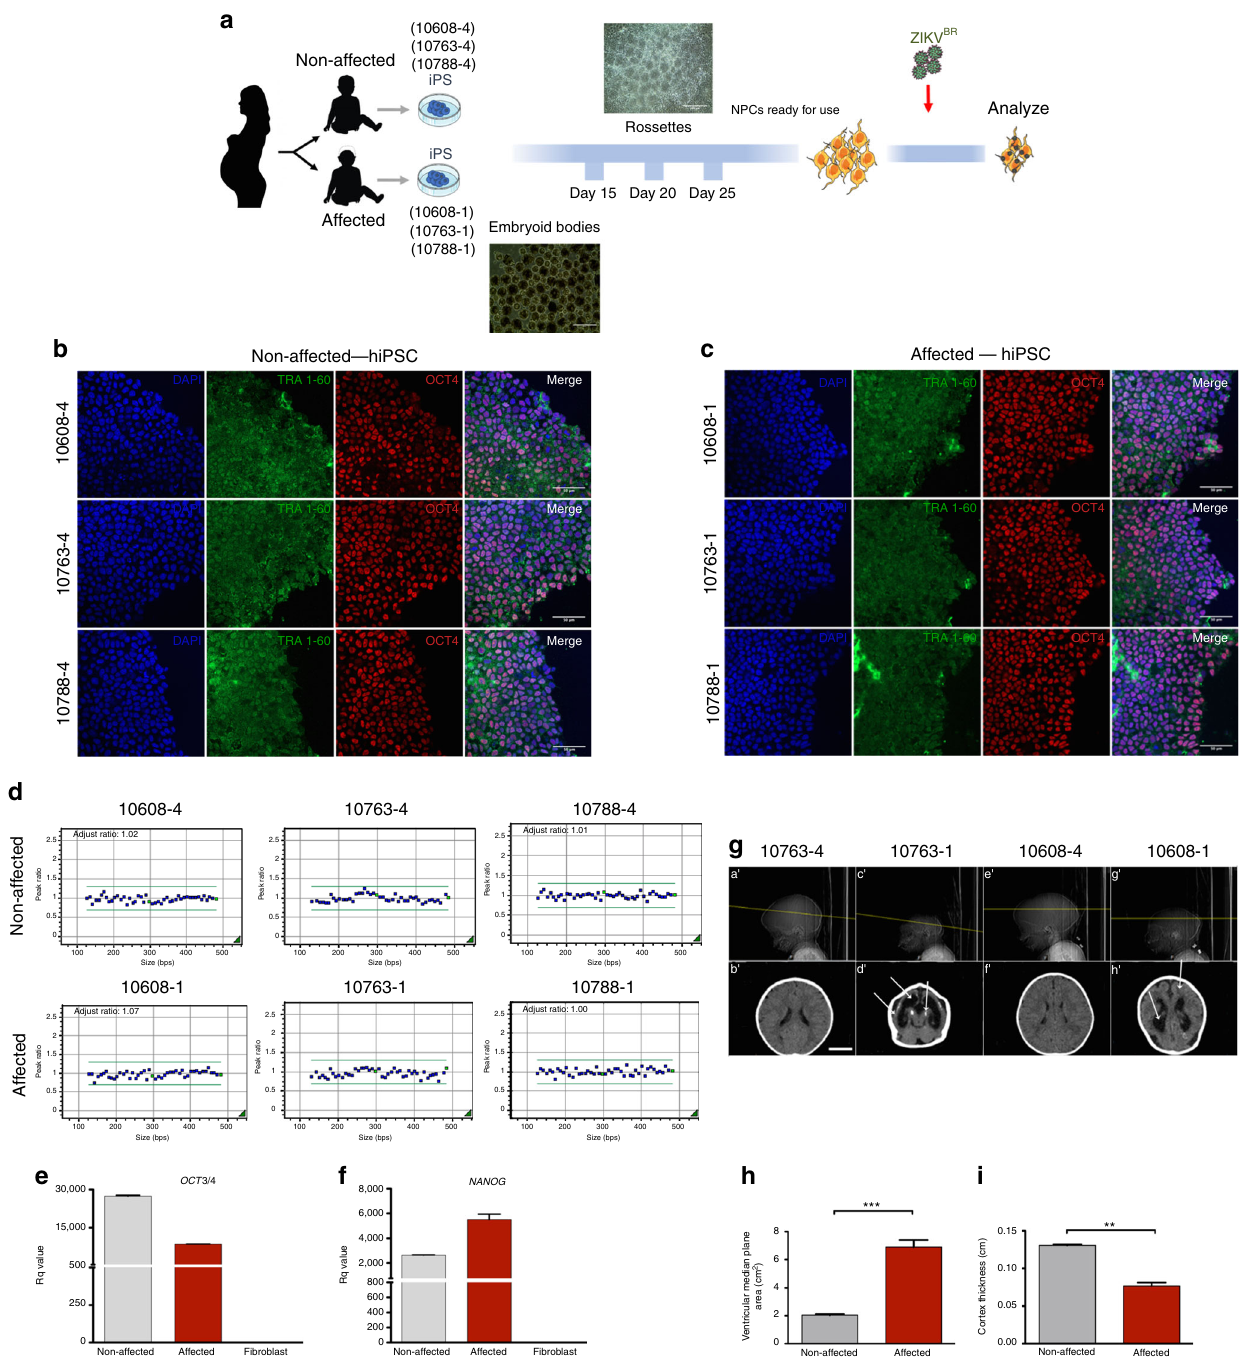
Fig. 1 Experiment design and hiPSC characterization. a Schematic: generation of neural progenitor cells (NPCs) from discordant twins ’ hiPSCs following ZIKV BR infection and analysis. Silhouettes are courtesy of www.vecteezy.com (mother) and Yulia Ryabokon (babies). b , c Immuno fl uorescence for TRA-1- 60 and OCT3/4 in hiPSCs. Scale bar, 20 μ m. d MLPA analysis of subtelomeric imbalance chromosomal abnormalities in cultured hiPSCs cell lines using P070 and P036 MLPA Kits. e , f RT-qPCR analysis of hiPSCs for OCT3/4 and NANOG expression (mean ± SEM). g Representative discordant twins ’ computed tomography (CT) scan images (a ′ , b ′ [#10763-4]; e ′ , f ′ [#10608-4] — non-affected babies; c ′ , d ′ [#10763-1], g ′ , h ′ [#10608-1] — affected babies). #10608 twins were 5 months old and #10763 were 15 months old when submitted to CT scan. White arrows show observed brain abnormalities (calci fi cations, ventriculomegaly, and cortical gyrus simpli fi cation). Scale bar, 3 cm. h Ventricular area analysis (cm 2 ) ( n = 4, two pairs of discordant twins). i Cortex thickness analysis ( n = 4, two pairs of discordant twins). *** p < 0.001; ** p < 0.01; mean ± SEM; Student ’ s t test RNA-Seq analysis . RNA sequencing (RNA-Seq) analysis of DZ NPCs from the affected and non-affected groups were compared. twins-derived NPCs prior to ZIKV infection showed 64 differ- The gene with the most signi fi cant ( p value = 1.45E − 07, corrected entially expressed genes (DEGs) ( p < 0.001, edgeR exact test, p value = 0.0058, edgeR exact test, Supplementary Data 3) dif- Supplementary Fig. 3a and Supplementary Data 3) when the ference in expression is DDIT4L , which is an inhibitor of mTOR NATURE COMMUNICATIONS | (2018) 9:475 | DOI: 10.1038/s41467-017-02790-9 |